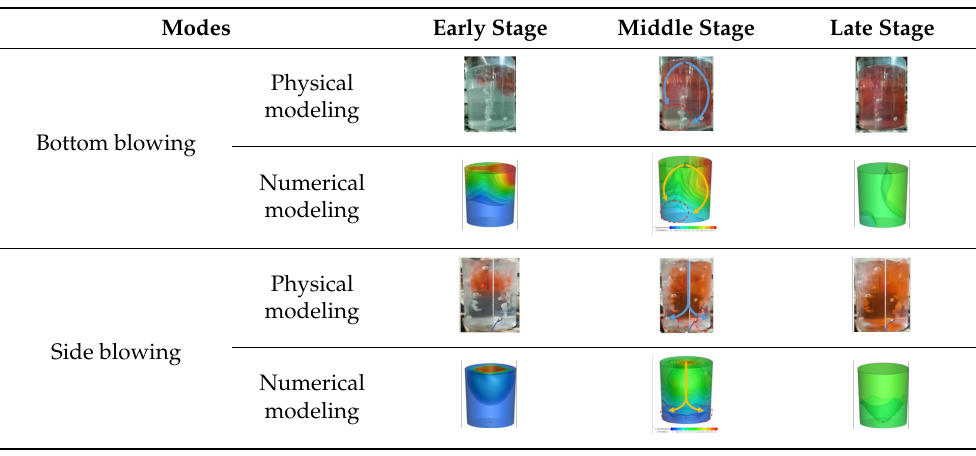
Table 7. Diffusion paths of KCl solution of bottom plugs and four side plugs at 116 mm in physical modeling and numerical modeling under the flow rate of 2.4 m 3